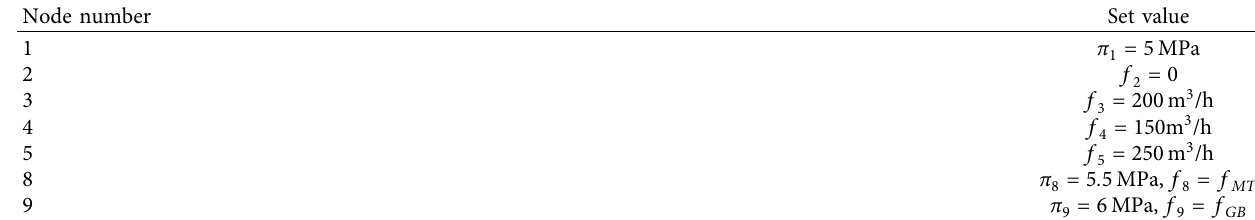
Table 7: Node parameter values of the natural gas subsystem.